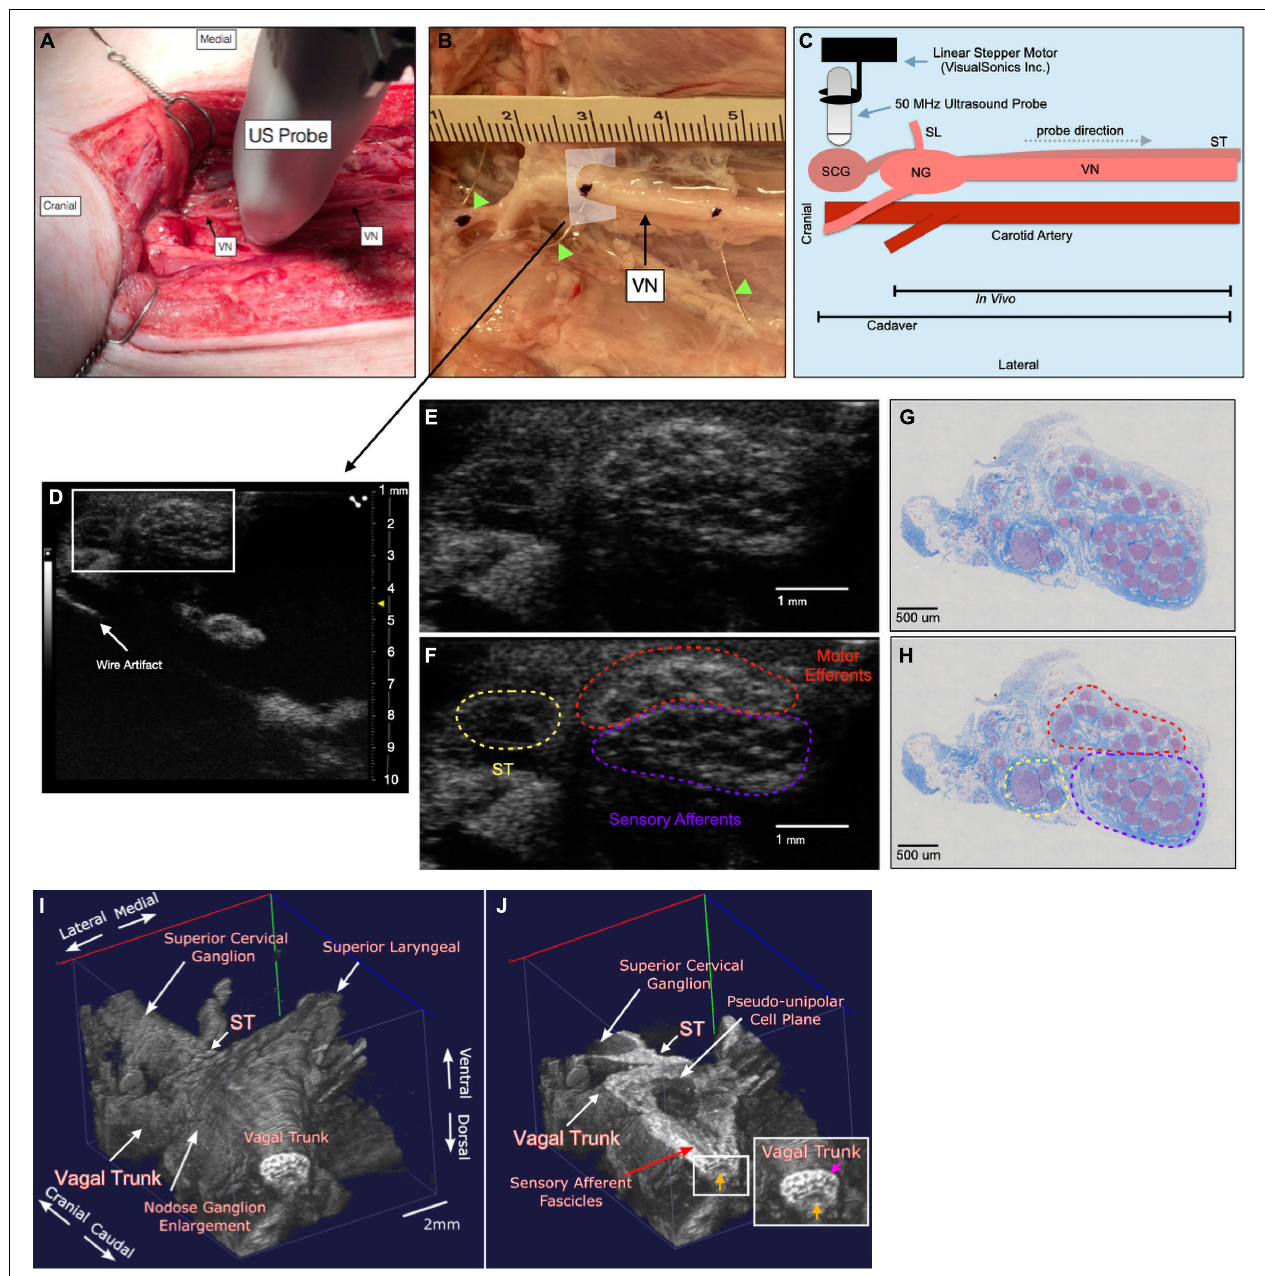
FIGURE 1 | Ultrasound method for visualizing the vagus nerve in a representative subject (A) the swine surgical window includes the right vagus nerve (VN) and the carotid artery, as well as the 50 MHz ultrasound probe (US probe) moving in the cranial to caudal direction. Skin, muscle, and fat were retracted in this acute preparation. (B) Representative VN in one of the cadaver subjects showing fiducial wire (green arrow heads) and histology dye as well as cross section of US plane (D) . (C) Schematic of the probe direction (gray dashed arrow) as it scanned from the nodose ganglion (NG) ( in vivo ) or superior cervical ganglion (SCG) (cadaver) moving caudally, approximately 10 cm. (D) Ultrasound cross section demonstrating bimodal fascicular organization within the surgical window, with wire fiducial marker and zoom of nerve indicated with white box (E,F) . (E,F) Zoomed region of ultrasound still (white box, D ) demonstrating sensory and motor bimodal arrangement (purple and red regions, respectively) as traced from the pseudo-unipolar cell plane of the nodose ganglion (See Supplementary Video , Cadaver Subject 1 for the full ultrasound video) The sympathetic trunk (ST), as traced from the SCG is indicated in yellow (G,H) A representative, paired histology section (5 µ m, Gomori’s trichrome) showing the bimodal organization of the vagus nerve within the surgical window, at the wire fiducial marker, indicating the bimodal sensory and motor fascicular organization, as indicated by the purple and red regions, respectively. The ST is indicated in yellow. (I) Subject 1 3D ultrasound data clearly showing the nodose ganglion and superior laryngeal extending ventromedially, and vagal trunk extending in the cranial and caudal direction. The superior cervical ganglion is just cranial to the nodose ganglion, with the sympathetic trunk (ST) running parallel to the vagus nerve along the dorsomedial aspect. (J) Coronal plane (ventral to dorsal) of vagus nerve showing axons extending from the pseudo-unipolar cell plane to the sensory afferent mode of the vagal trunk. In the zoomed region of the vagal trunk, sensory afferent fascicles are indicated by the yellow arrow, and motor efferent fascicles are indicated by the pink